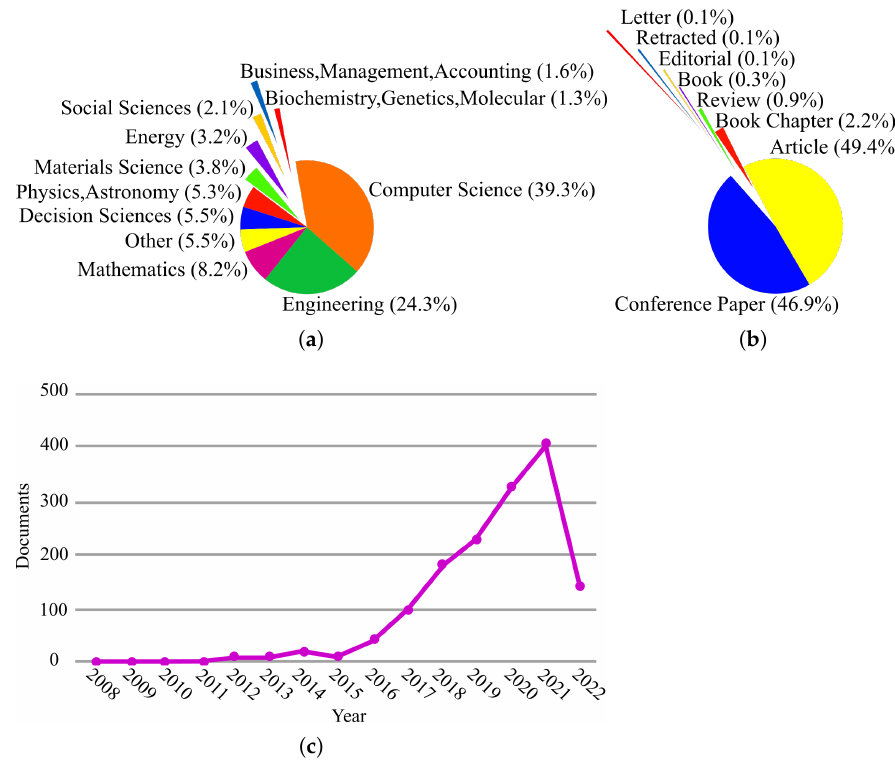
Figure 2. Search statistics extracted from Scopus related to the application of SI in IoT: ( a ) per subject area, ( b ) per publication type, and ( c ) per